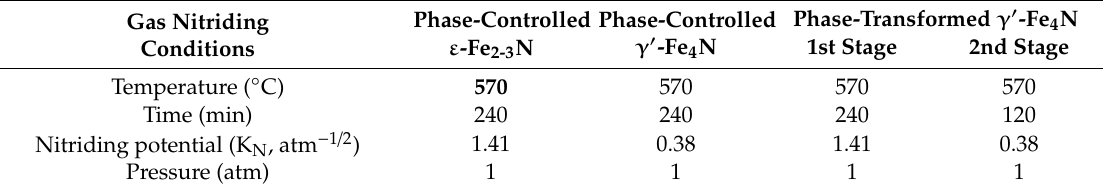
Table 2. Experimental conditions of gas-nitrided pure iron with various nitriding potential. Phase-Transformed γ (cid:48) -Fe 4 N Phase-Controlled Phase-Controlled Gas Nitriding γ (cid:48) -Fe 4 N ε -Fe 2-3 N 1st Stage 2nd Stage Conditions Temperature ( ◦ C) 570 570 570 570 Time (min) 240 240 240 120 Nitriding potential (K N , atm − 1 / 2 ) 1.41 0.38 1.41 0.38 Pressure (atm) 1 1 1